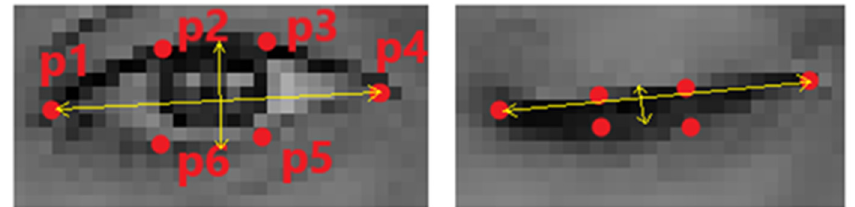
Figure 8. The states of the landmarks according to the open and closed position of